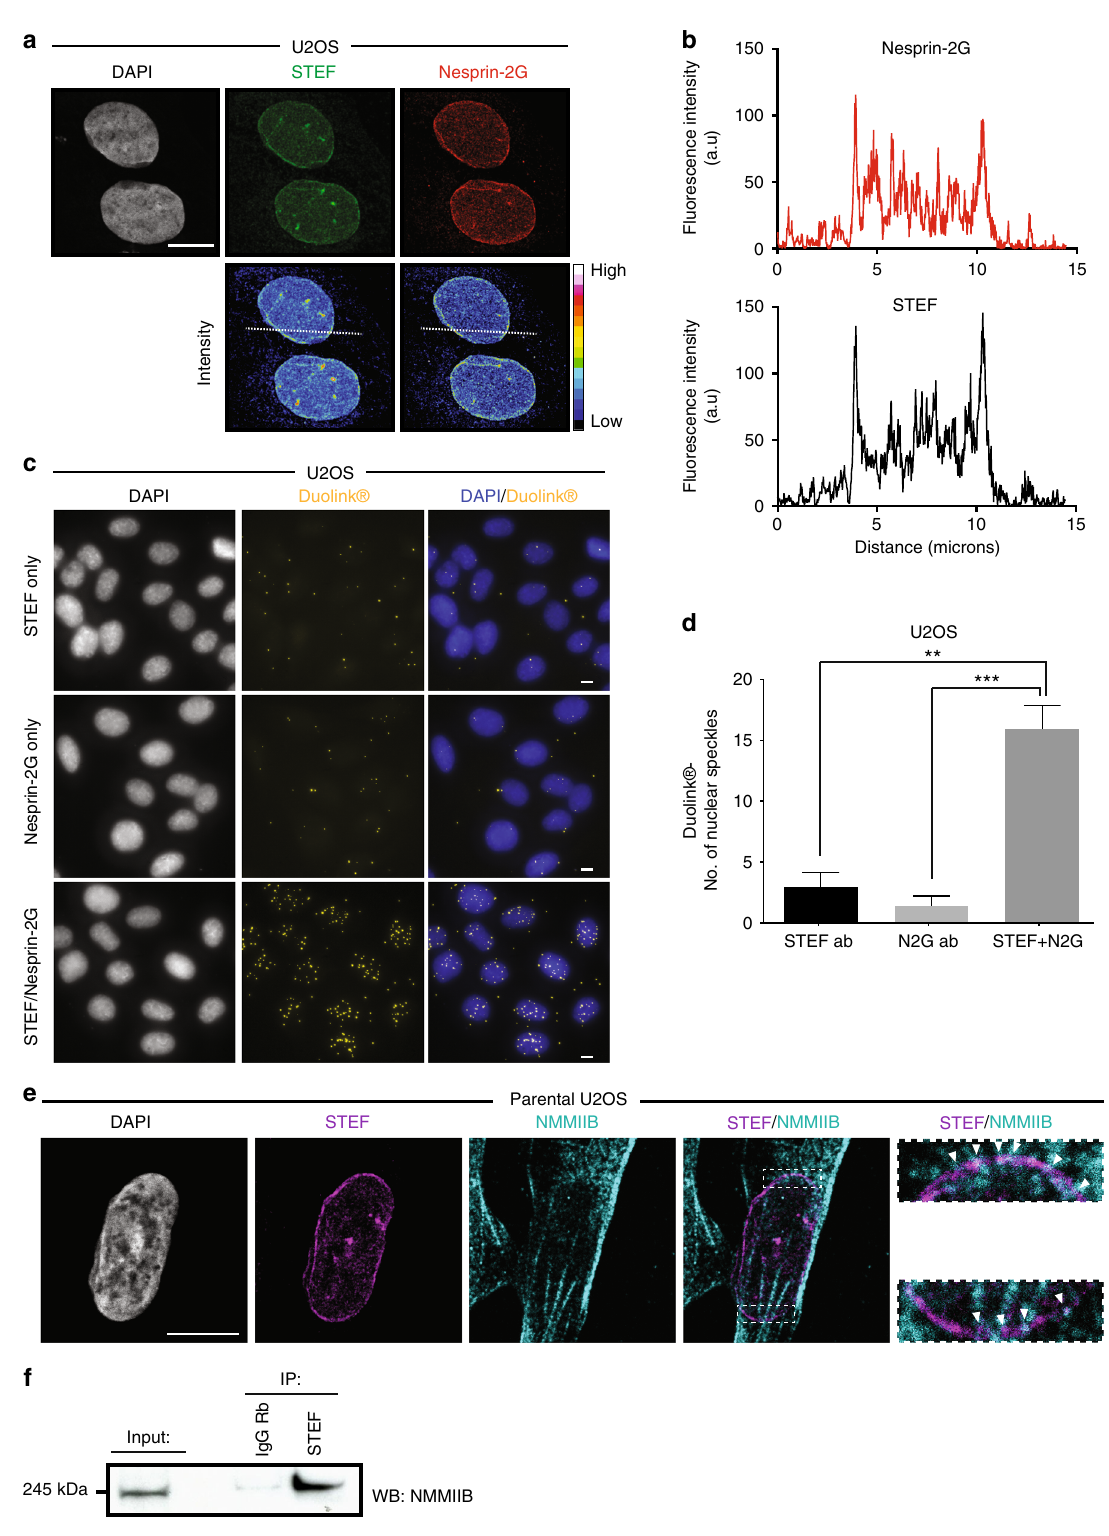
(Fig. 4b), con fi rming that STEF regulates the activity of Rac1 adjacent to the nuclear envelope. To further investigate the role of perinuclear Rac1 activity in the formation and/or maintenance of the actin cap, we